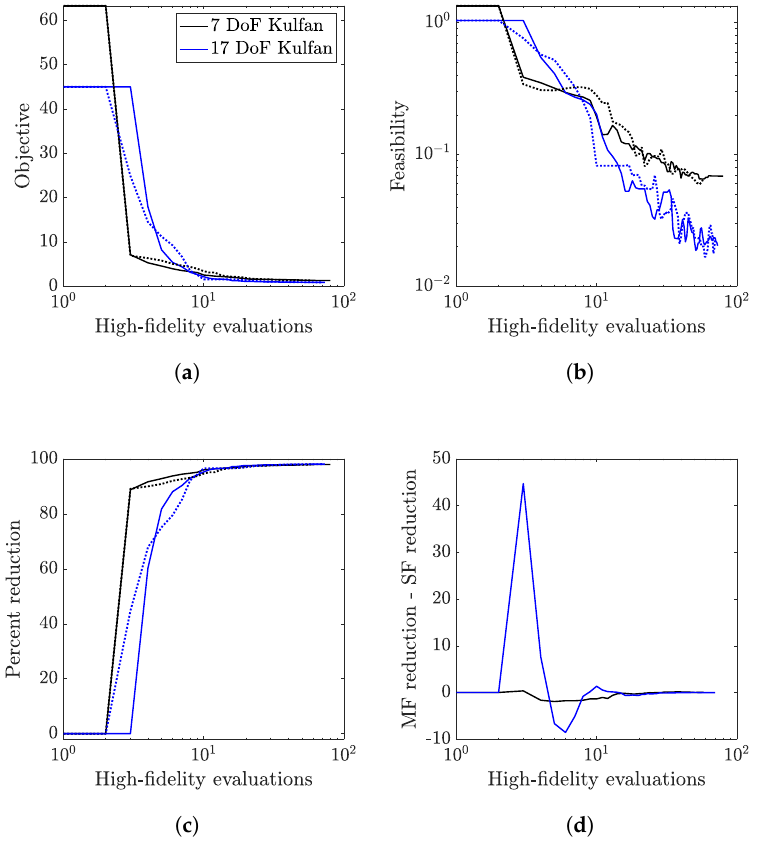
Figure 12. Optimization results for structural sizing cases, fixed airfoils. ( a ) Penalty-constrained objective; ( b ) Feasibility; ( c ) Percent reduction, all; ( d ) Percent reduction,